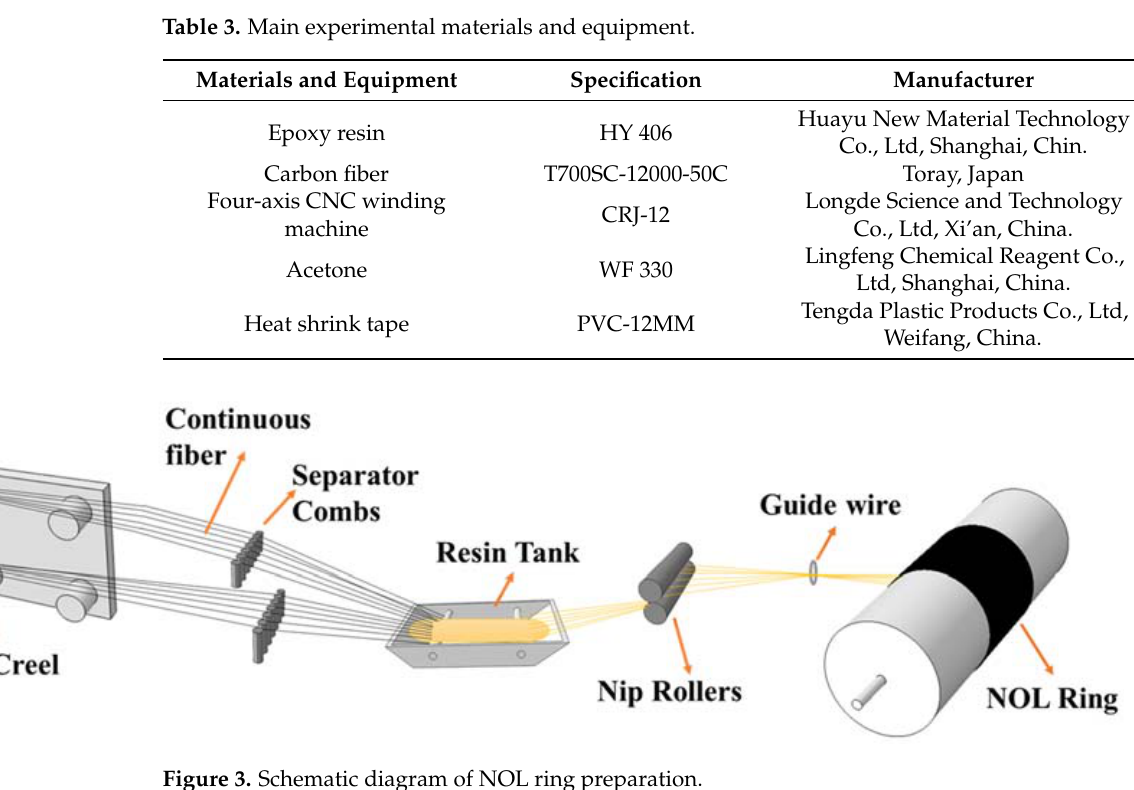
Figure 3. Schematic diagram of NOL ring preparation.